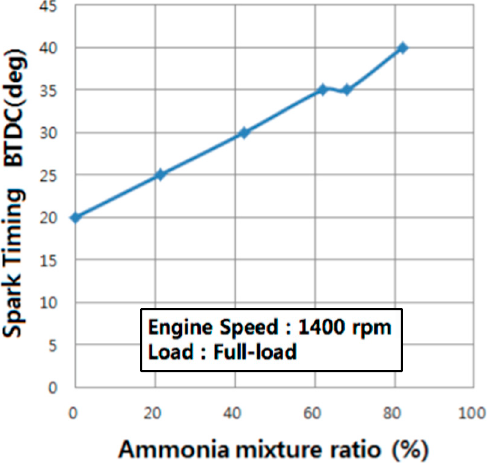
Figure 12. Torque and spark timing required for the mixing of ammonia to petrol (adapted from [100]).